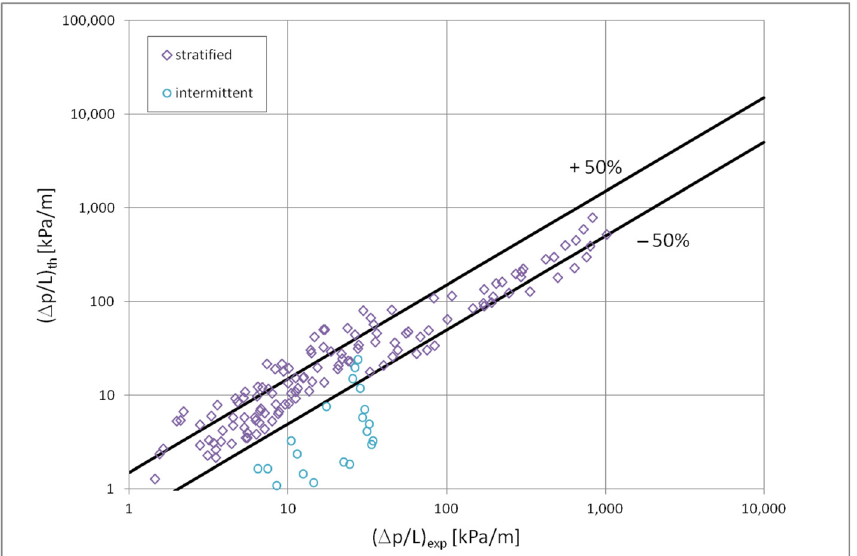
Figure 17. Comparison of the results of experimental research on the condensation of the R404A refrigerant in pipe mini-channels with the calculations according to the author’s correlation (3) describing the pressure drops in the scope of the stratified and intermittent flow.